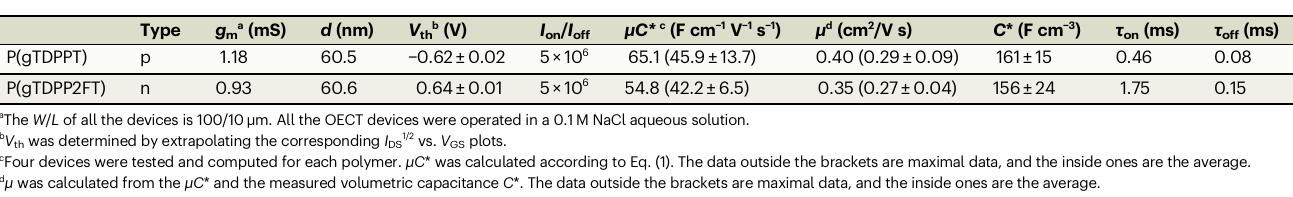
Fig. 3 | OECT device characterization of P(gTDPPT) and P(gTDPP2FT). a , b Transfer characteristics and c , d output characteristics of P(gTDPPT) and P(gTDPP2FT). The dash lines are the curve of g m . e , f Transient on/off curves with V GS of 0~ − 0.9 and 0 – 0.9V for P(gTDPPT) and P(gTDPP2FT), respectively. Device con fi guration: W/L =100/10 μ m, | V DS |=0.6V. g Voltage transfer Table 1 | Summary of the OECTs performance of the